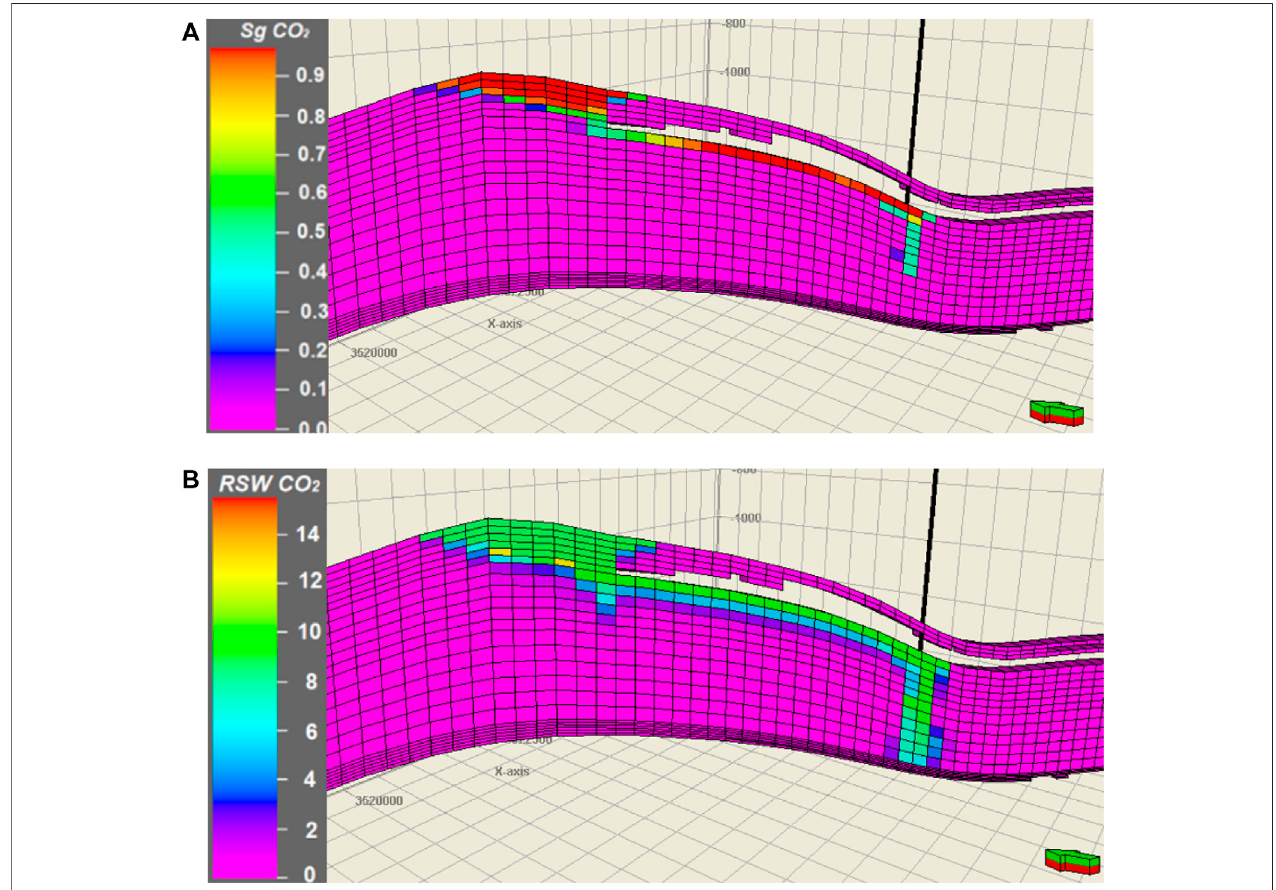
FIGURE 11 | Distribution of free CO 2 saturation in the structure (A) and CO 2 dissolved in brine (B) after 25 years of injection.